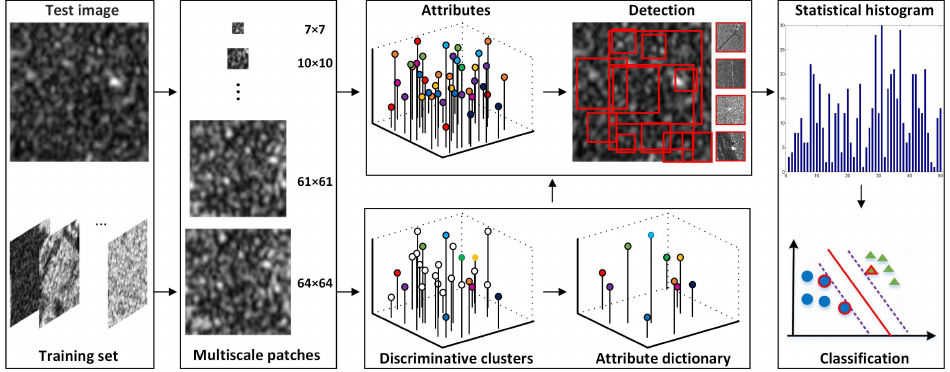
Figure 4. Framework of SAR image classification based on attributes. The first step is low-level features extraction; then, the attributes that appeared in the test image are detected, and the frequency of the detected attributes is described by a statistic histogram; finally, a linear SVM classifier is used to perform